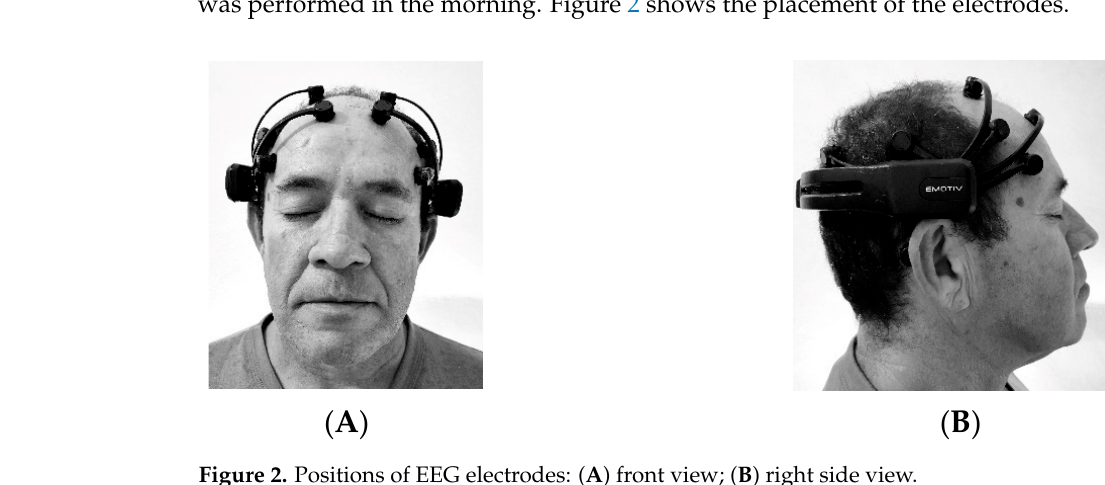
Figure 2. Positions of EEG electrodes: ( A ) front view; ( B ) right side view.